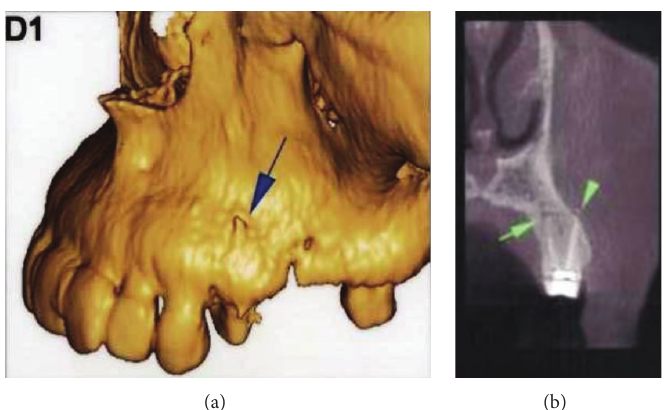
Figure 5: (a) 3D image and (b) coronal view of DVT revealed that the apex of the buccal root canal had perforated the maxillary cortical bone.